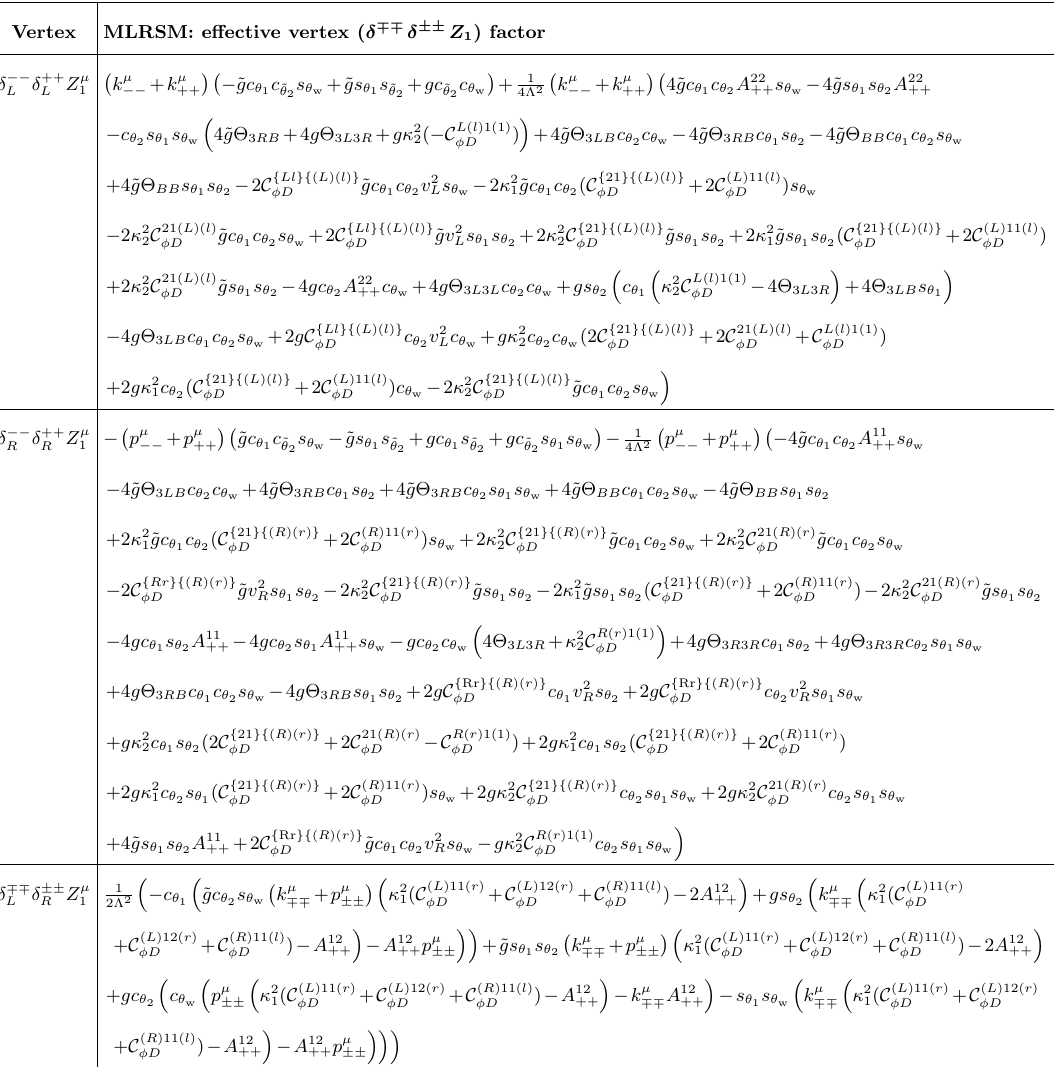
and (cid:14) (cid:6)(cid:6) L R